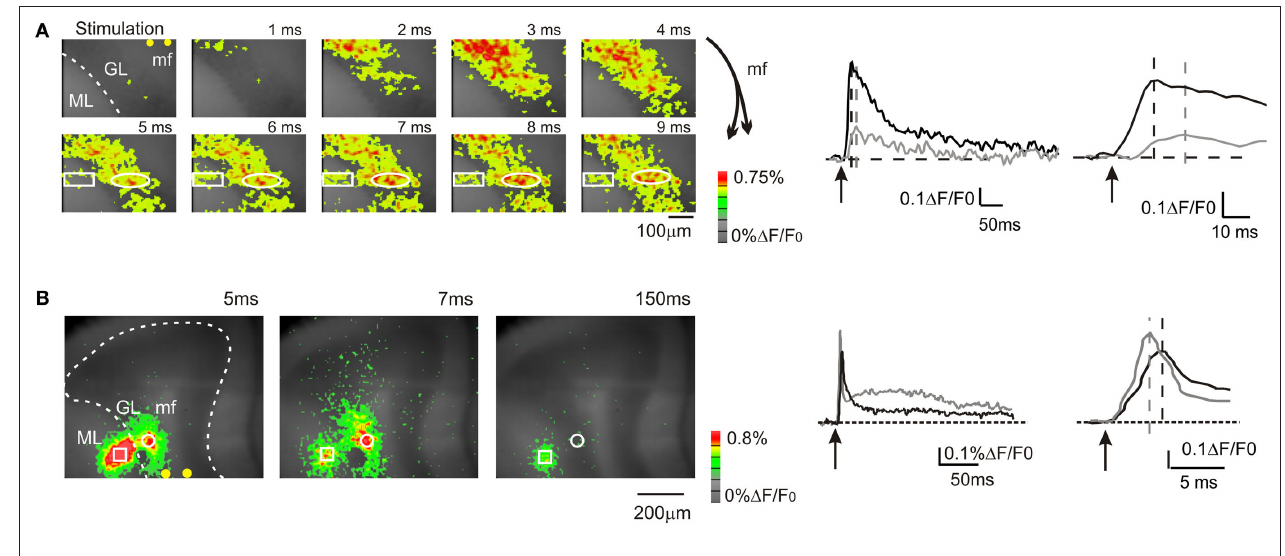
FiGure  | Mossy fiber and climbing fiber responses to white matter stimulation. VSD imaging in parasagittal slices of the cerebellar vermis. In this and in the following figures: mf, mossy fiber; GL, granular layer; PC, Purkinje cell layer, ML, molecular layer, pf, parallel fiber. In this and the following figures, yellow dots indicate stimulation electrodes. (A) Optical maps of responses evoked by a single stimulus delivered to the white matter (arrowhead), illustrating the sequence of granular to molecular layer activation through the mossy fibers. Maps show the temporal evolution of granular and molecular layer activation with a time resolution of 1 ms. In the granular layer, the optical signal rapidly propagates from the stimulation site with short delay (2–3 ms) and peaks in 5–6 ms. The activity propagates in a restricted region of the molecular layer (rectangle) with a further delay of 3 ms compared to the corresponding granular layer activation (circle). The traces illustrate the time